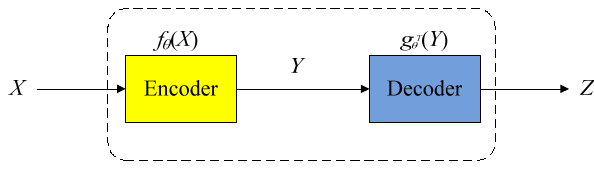
Figure 8. Working principle of the SDAE.